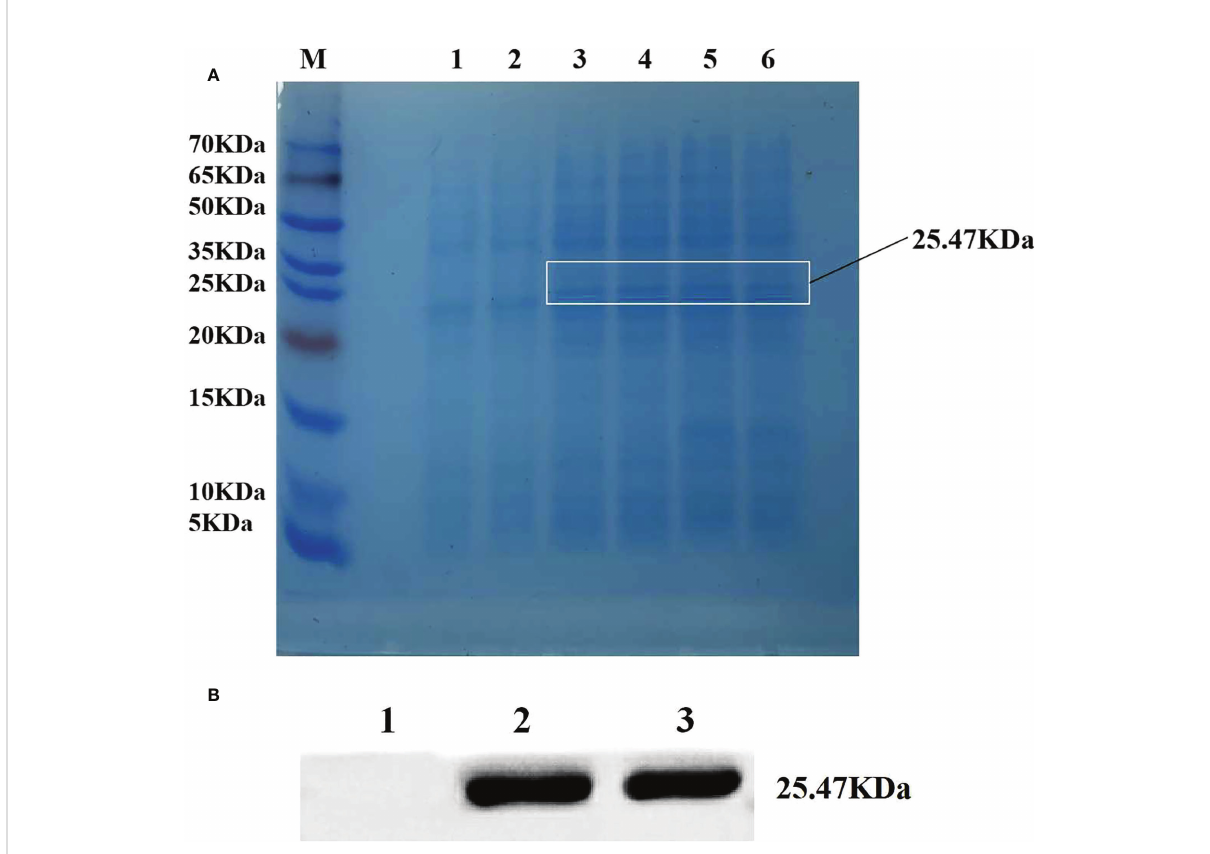
FIGURE 3 Ef fi cient expression of ZmLBD2 in a prokaryotic system. (A) SDS-PAGE electrophoretic analysis of ZmLBD2 recombinant protein. M: Protein marker; 1: pET22b empty vector was not induced by IPTG; 2: pET22b-ZmLBD2 non-induced bacteria; 3-6: pET22b-ZmLBD2 was produced by IPTG for 4 h. (B) Western blotting detection of ZmLBD2 protein; 1: pET22b empty vector; 2-3: pET22b-ZmLBD2 after